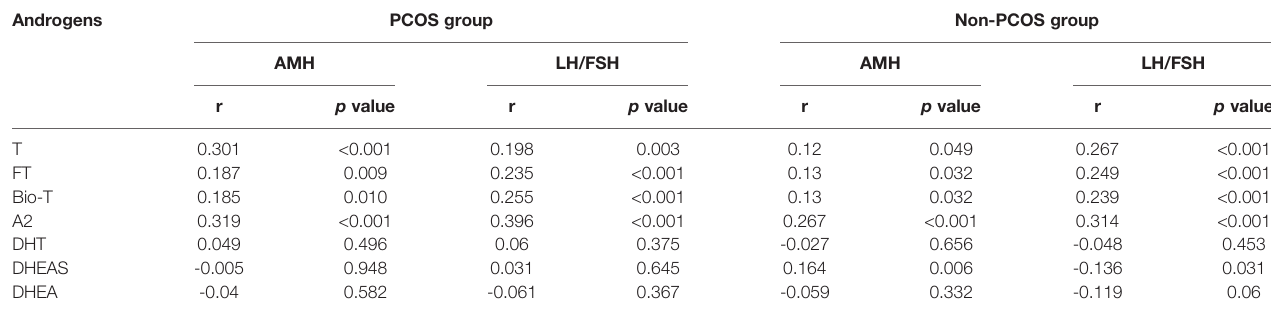
TABLE 3 | Pearson correlation analysis between androgens and AMH or LH/FSH. Androgens